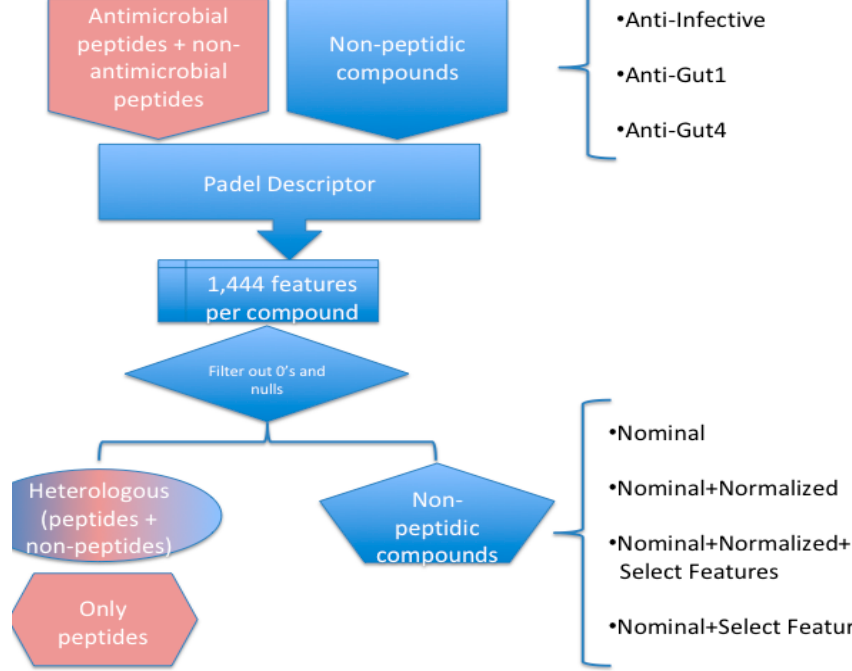
Figure 7. Dataset construction. The steps described to build the datasets (anti-infective, anti-gu1, and anti-gut4) used throughout this work are described. From 1,181 non-peptidic compounds and 11,545 peptides, three sets were derived: heterologous, only peptides and non-peptidic compounds. Each of these sets was converted into ARFF format using the specified combination of the following procedures: nominal representation of the class (antimicrobial or non-antimicrobial), features normalized, and/or feature selection.